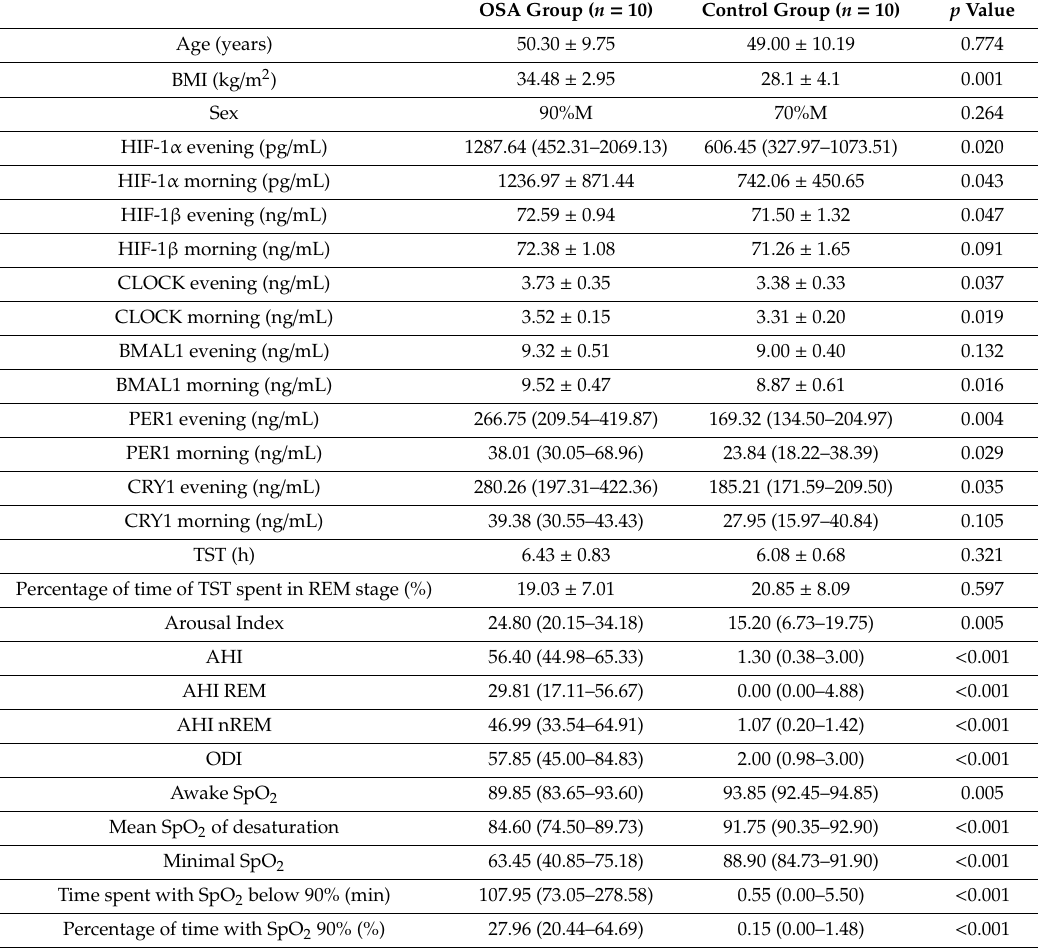
Table 1. Comparison of the study